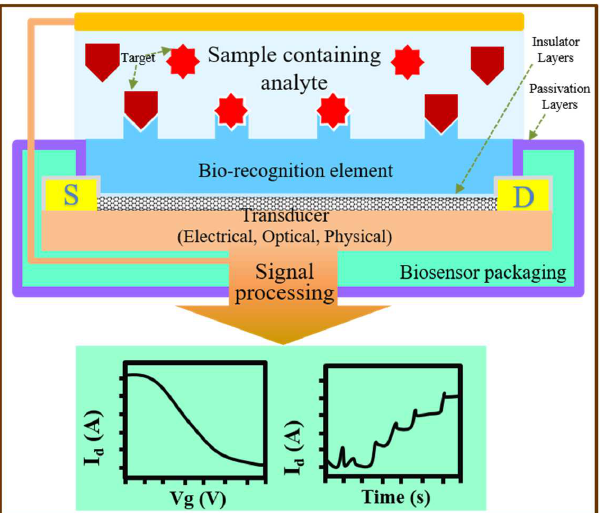
Figure 1. Schematic diagram of the working principle of biosensors based on single-walled carbon nanotube field-effect transistors.